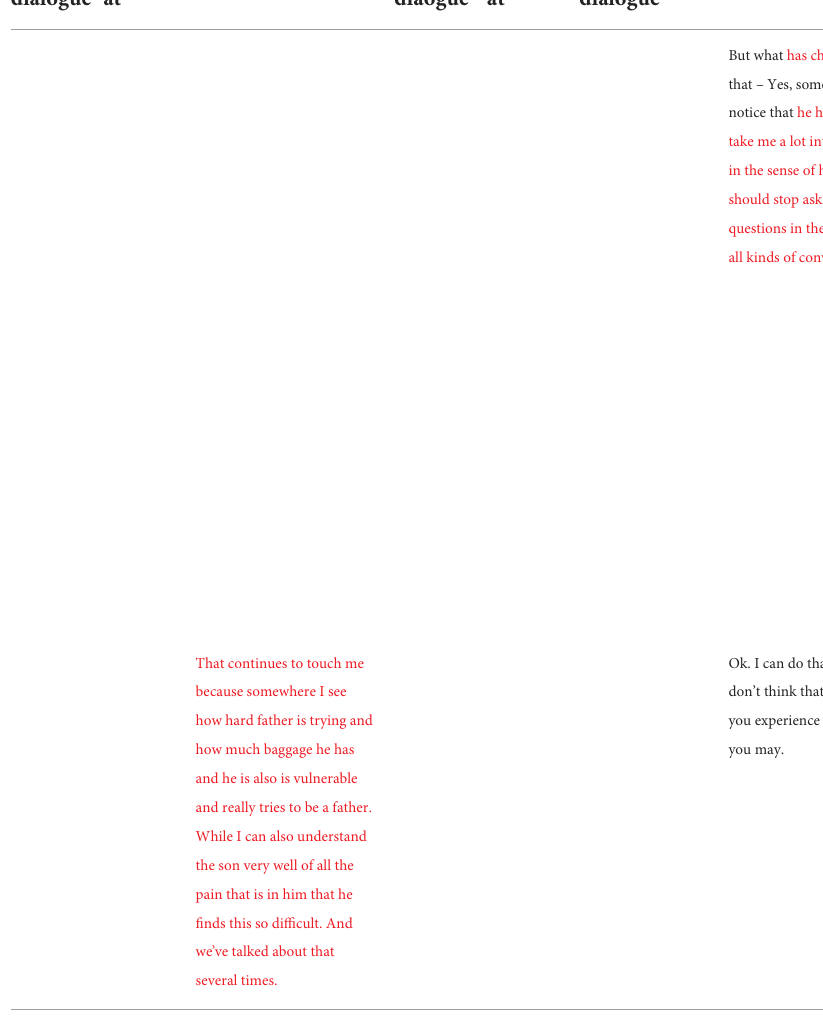
TABLE 1 Analysis matrix absence of reflections. Social worker 1 Social worker 2 Outer